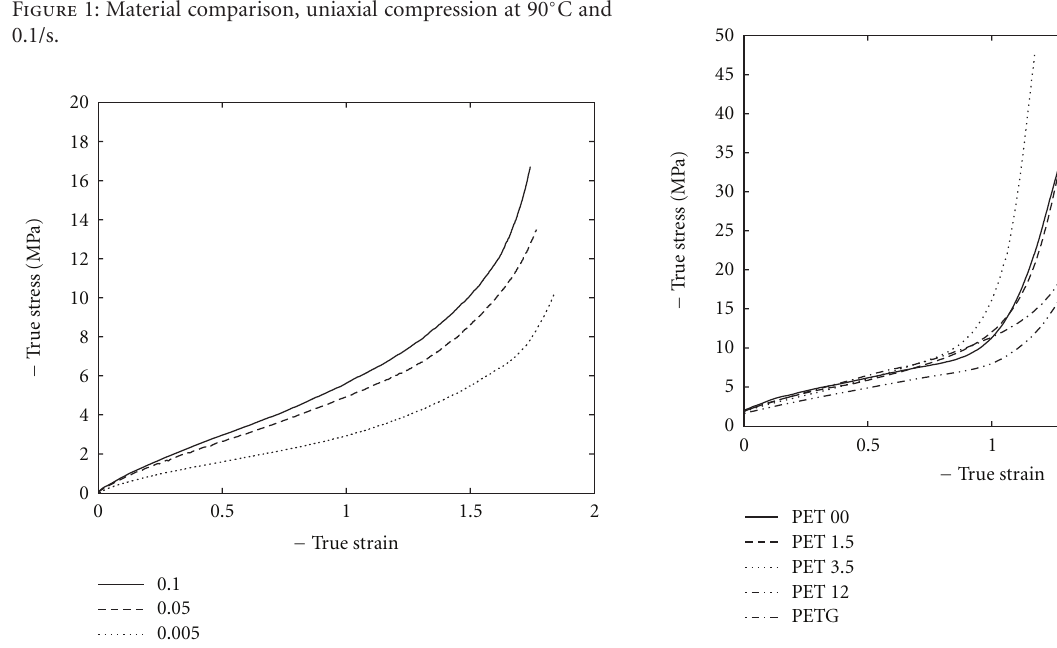
Figure 2: Strain rate comparison, PET00, and uniaxial compression at 90 ◦ C.